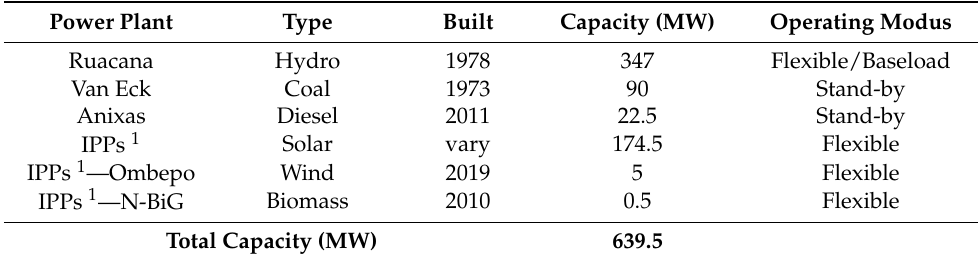
Table 1. Existing power production plants in Namibia